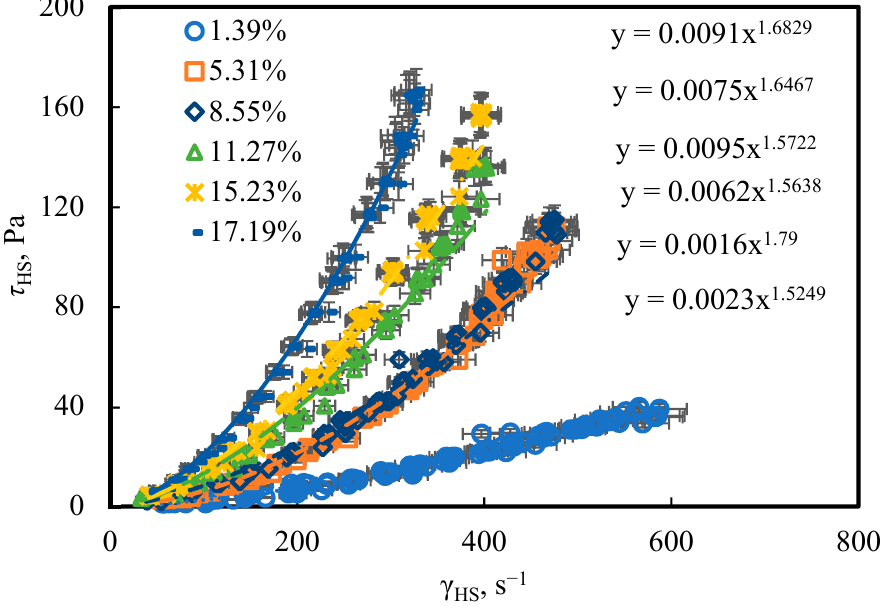
Figure 4. Representation of shear stress and shear stress for CO 2 hydrate concentrations from 1.39 to 17.19 vol%.